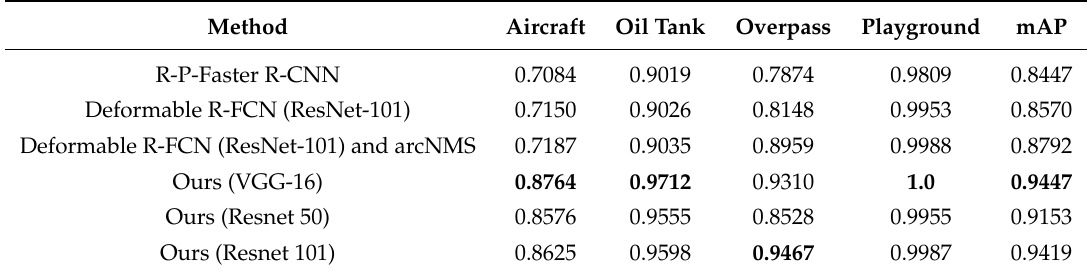
Table 4. Performance Comparison between the proposed model and the state-of-the-art models on RSOD